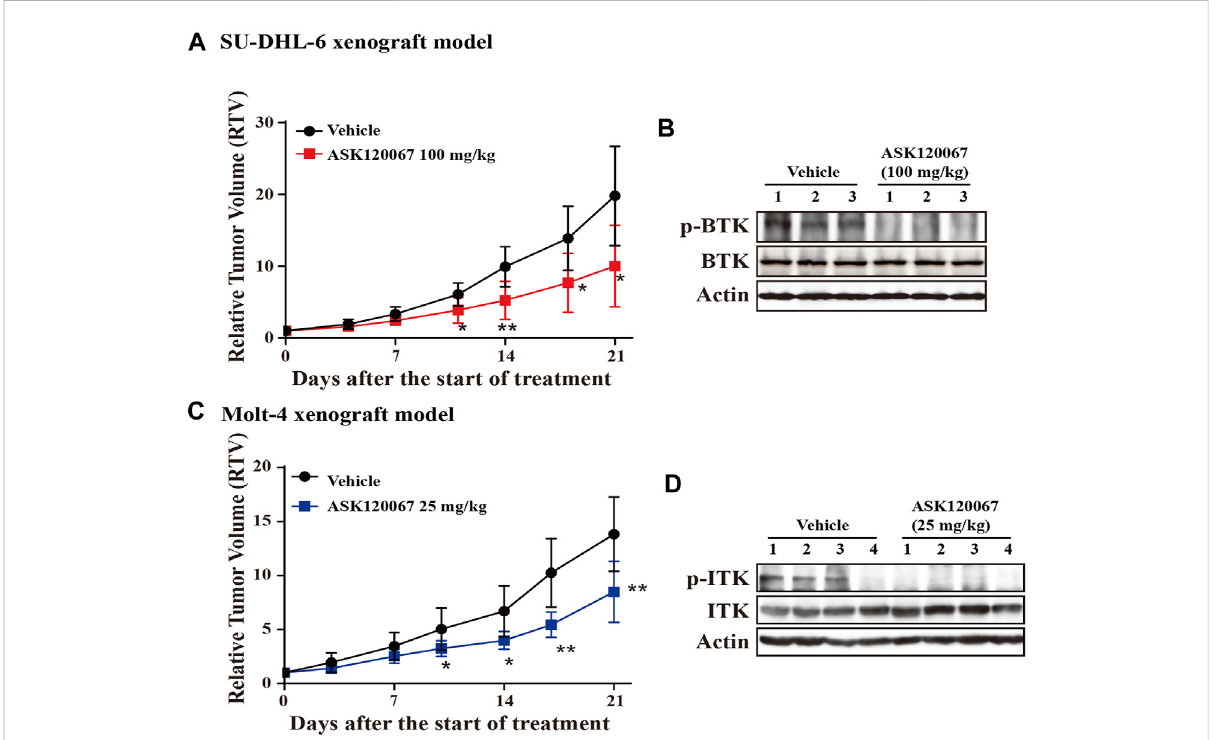
FIGURE 5 OraladministrationofASK120067inhibitedtumorgrowthinsubcutaneousxenograftsusingSU-DHL-6cellsorMolt-4cells. (A) Tumor-growth curve of a subcutaneous xenograftmodel in mice using SU-DHL-6 cells. Vehicle-group mice were treated with 1% Tween 80, and treatment-group mice were administered ASK120067 (100 mg/kg, p.o.) once a day for 21 days. Tumor size was measured twice a week. Data are the mean ± SD. The Student ’ s t -test was conducted to compare the relative tumor volume of ASK120067-treated tumors vs. vehicle-treated tumors (* p < 0.05; ** p < 0.01). (B) Expressionofp-BTKintumortissueafterinjectionofSU-DHL-6cellswasevaluatedbywesternblottingafter21 daysoftreatment. (C) Tumor growth of the subcutaneous xenograft model using Molt-4 cells was monitored after mice had been given vehicle or ASK120067 (25 mg/kg, p.o.) once a day for 21 days. Tumor size was measured twice a week. The Student ’ s t -test was conducted to compare the difference in ASK120067- treated tumors vs. vehicle-treated tumors. * p < 0.05; ** p < 0.01. (D) Effects of 21 days of ASK120067 treatment on p-ITK expression in tumor tissue after injection of Molt-4 cells was evaluated by western